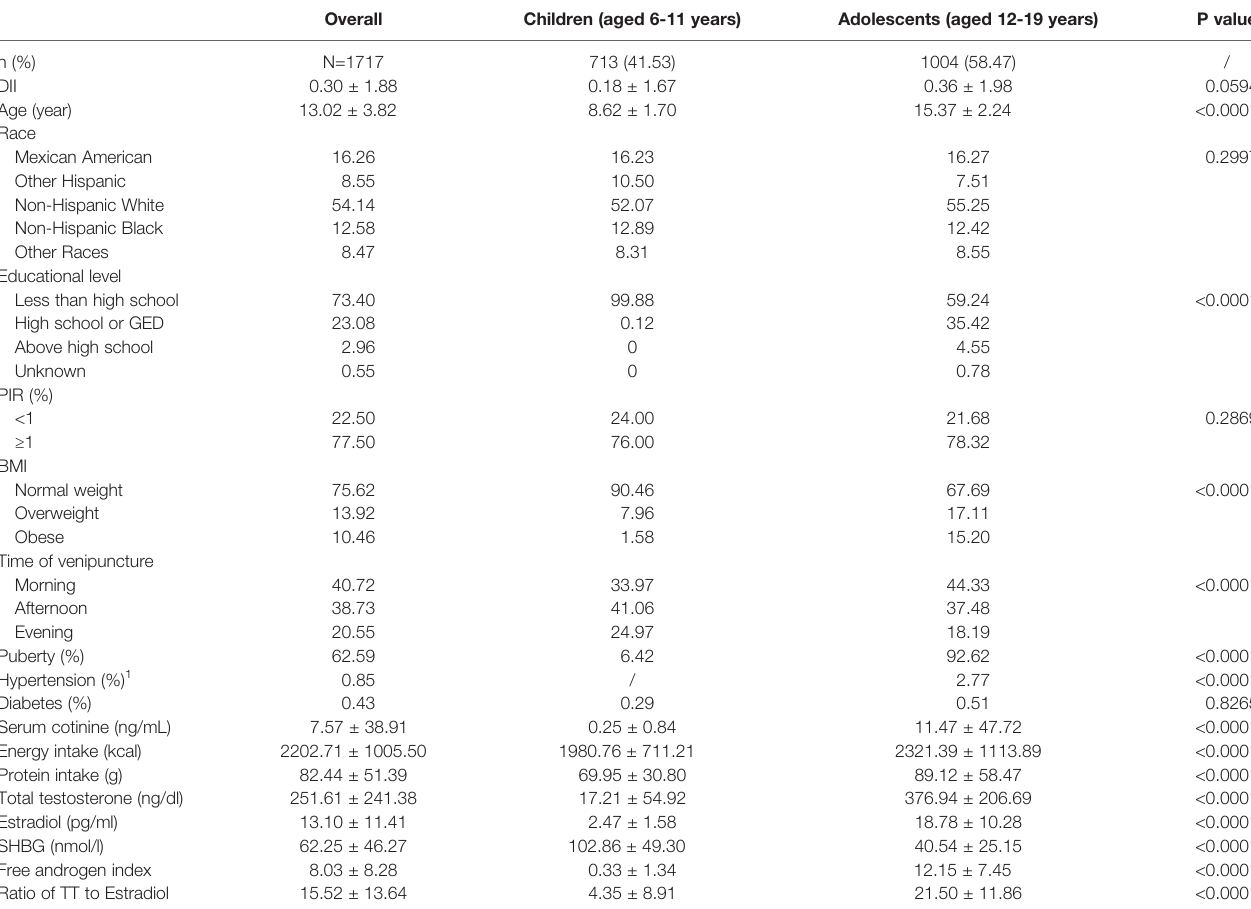
TABLE 1 | Baseline characteristics of participants,